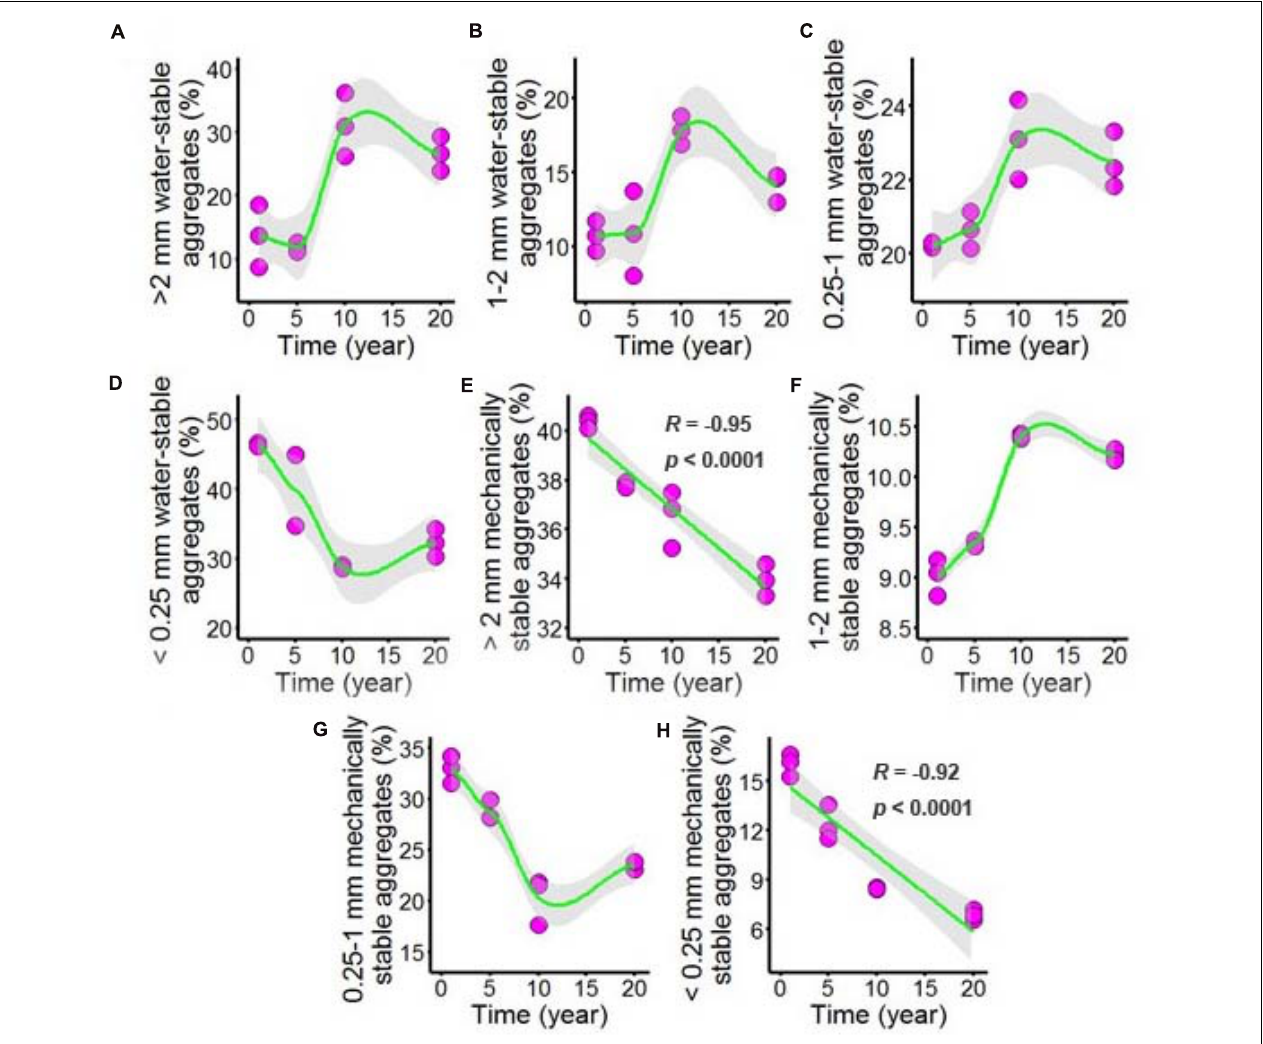
FIGURE 2 | Effect of long-term chili monoculture on the aggregates of rhizosphere soil. Long-term chili monoculture altered > 2 mm water-stable aggregates (A) , 1–2 mm water-stable aggregates (B) , 0.25–1 mm water-stable aggregates (C) , < 0.25 mm water-stable aggregates (D) , > 2 mm mechanically stable aggregates (E) , 1–2 mm mechanically stable aggregates (F) , 0.25–1 mm mechanically stable aggregates (G) and < 0.25 mm mechanically stable aggregates (H) . Soil aggregates show different patterns of response to continuous cropping duration (1, 5, 10, and 20 years), including linear and nonlinear relationships. Solid lines represent linear or LOESS fits, and gray areas denote the 95% confidence